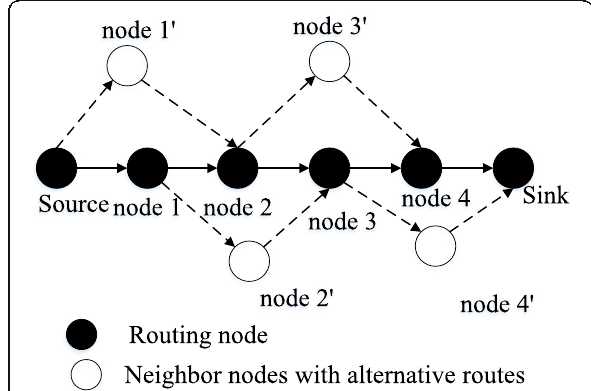
Fig. 5 Data transmission on the routing Path